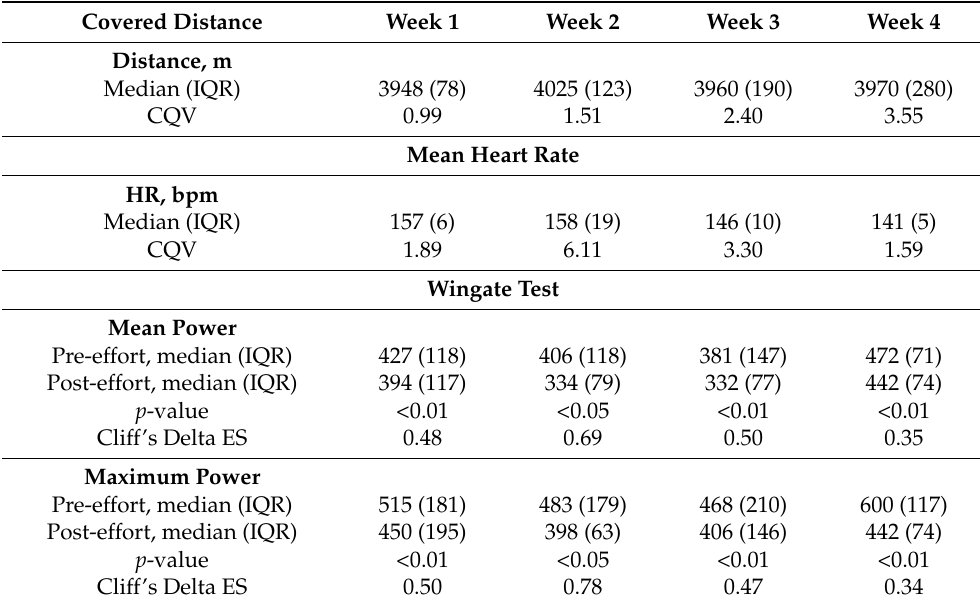
Table 2. Median values, IQR and CQV for the covered distance, mean heart rate, mean and minimum power together eith the wilcoxon p -values and cliff’s delta effect size.